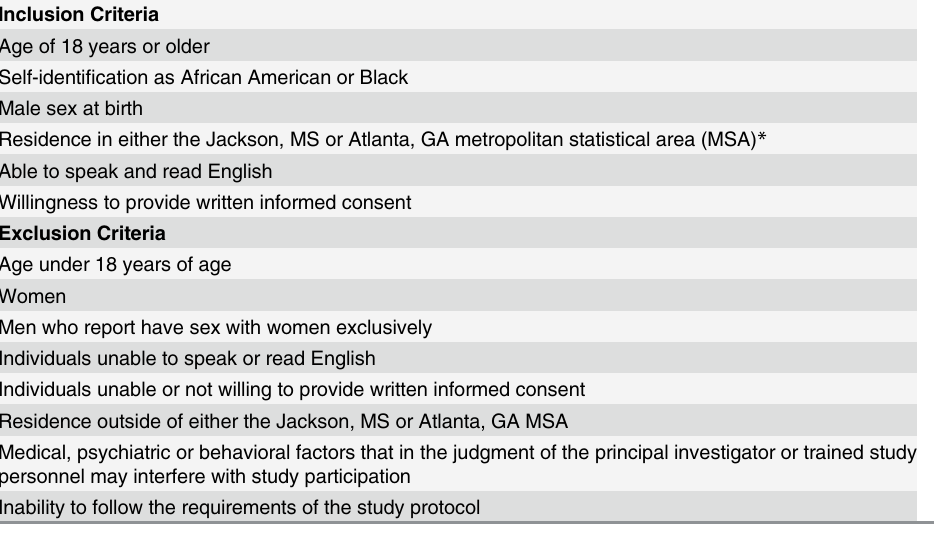
Table 1. The MARI Study Inclusion and Exclusion